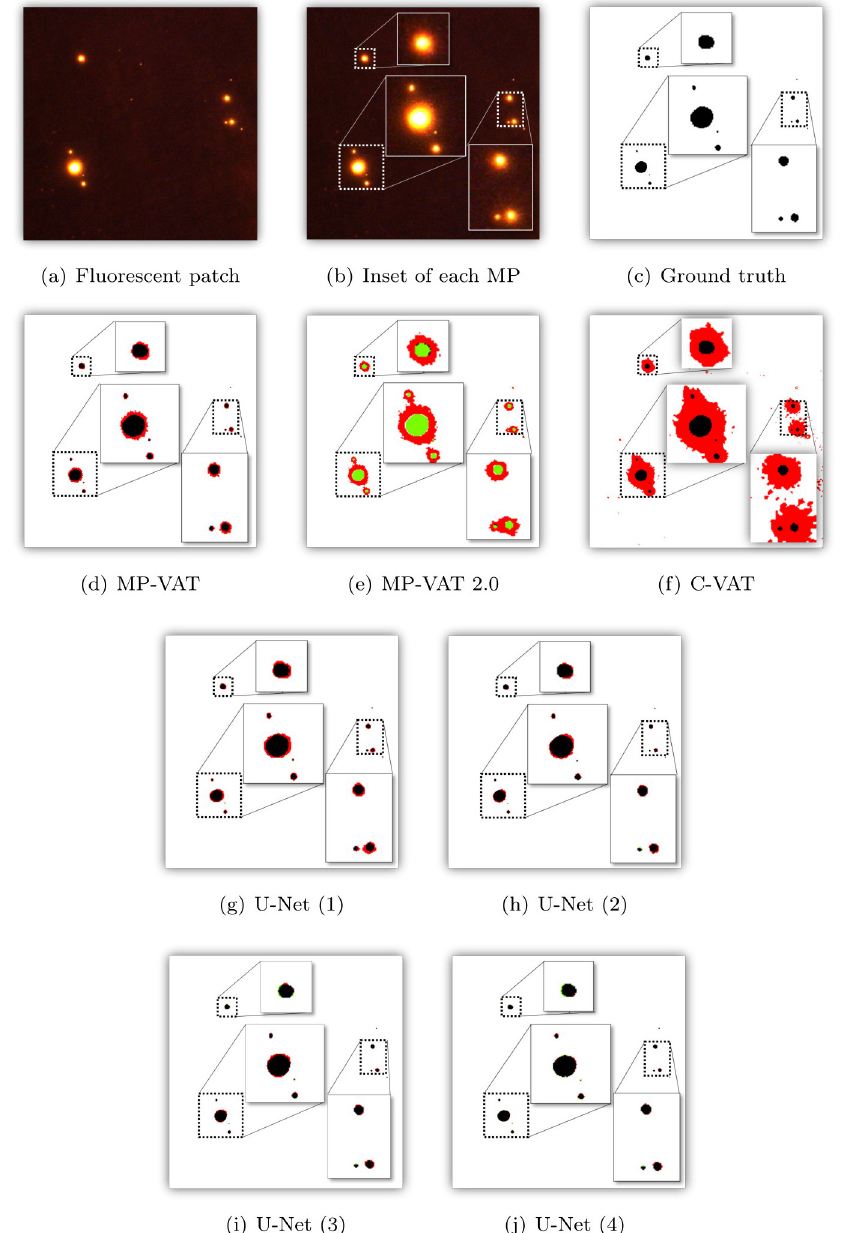
Fig 9. Visual comparison of the masks generated when making use of MP-VAT, MP-VAT 2.0, C-VAT, and the U-Net variations. For better visualization and understanding, regions with MP are also represented by making use of zoomed-in insets. Black denotes MP that has been correctly predicted (TP), red denotes predicted MP that is not MP (FP), and green denotes MP that has not been predicted as MP (FN). (a) Fluorescent patch. (b) Inset of each MP. (c) Ground truth. (d) MP-VAT. (e) MP-VAT 2.0. (f) C-VAT. (g) U-Net (1). (h) U-Net (2). (i) U-Net (3). (j) U-Net (4).